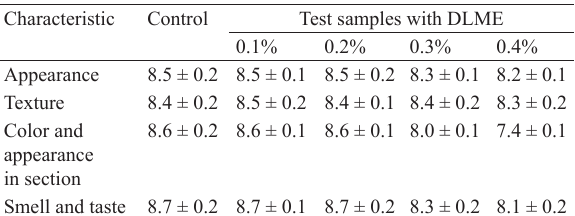
accumulation of primary lipid decomposition products during storage. Table 3 Sensory characteristics of paste samples with dry lingonberry marc extract Characteristic